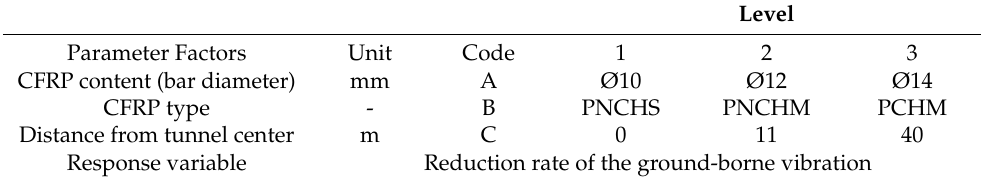
Table 7. Factor and level selected in this